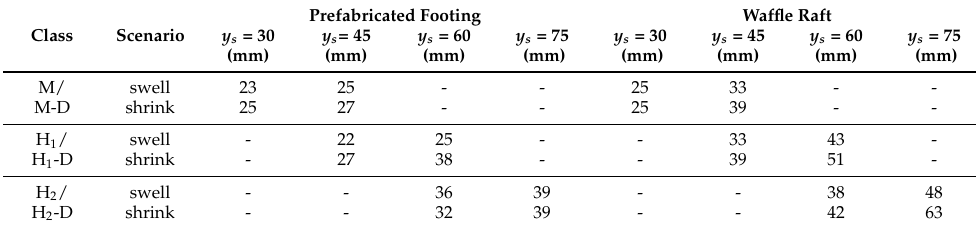
Table 7. Deformation, ∆ , of footing systems on shrinking and swelling soil considering site classifica- tion based on soil surface characteristic movement, y s in millimetres Standards Australia